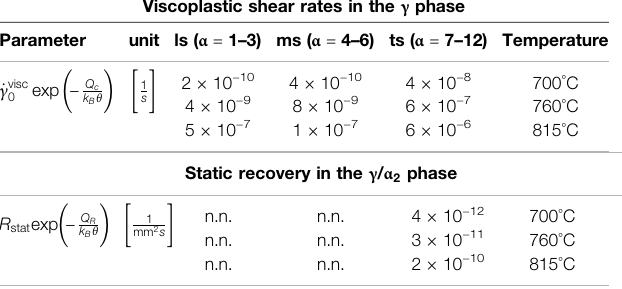
TABLE 7 | Viscoplastic shear rates and static recovery rates that have been identi fi edtoreproducethePSTcrystalstestedinParthasarathyetal.(2000)as a function of temperature. Viscoplastic shear rates in the γ